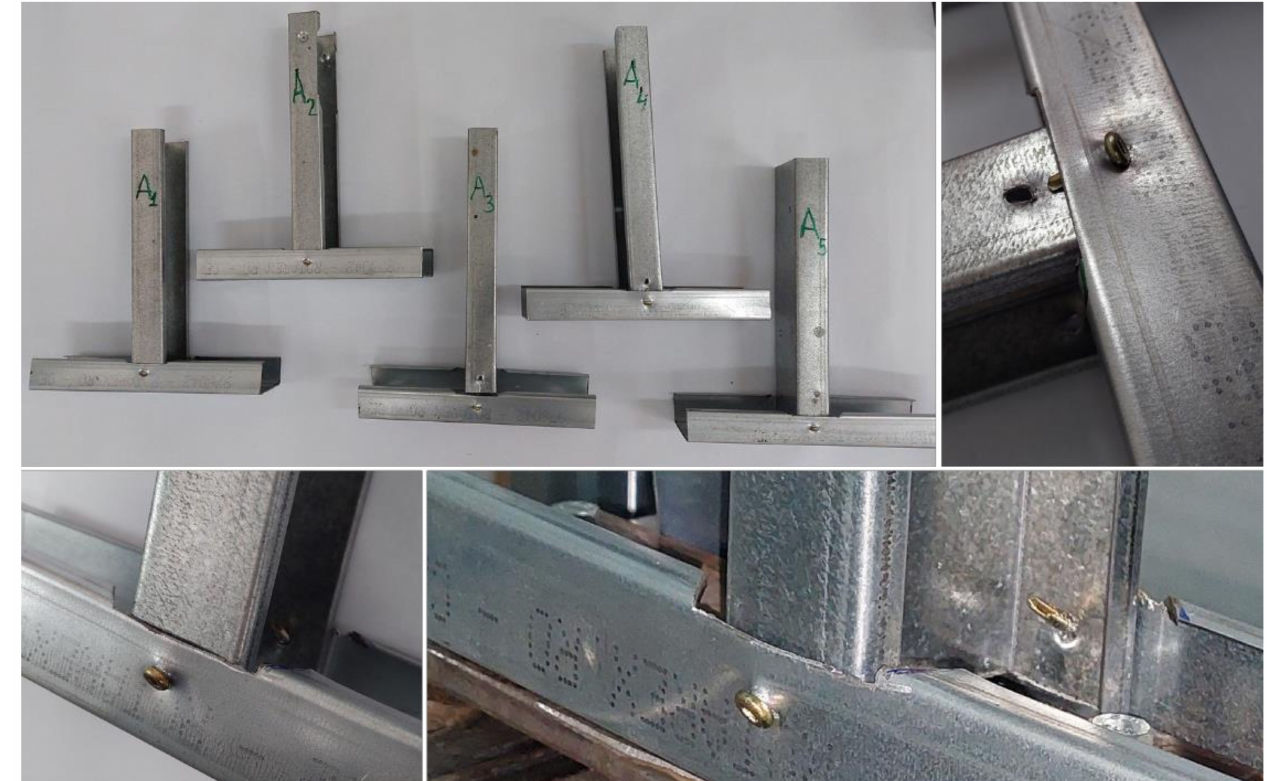
Figure 16. Joint A tested specimens.